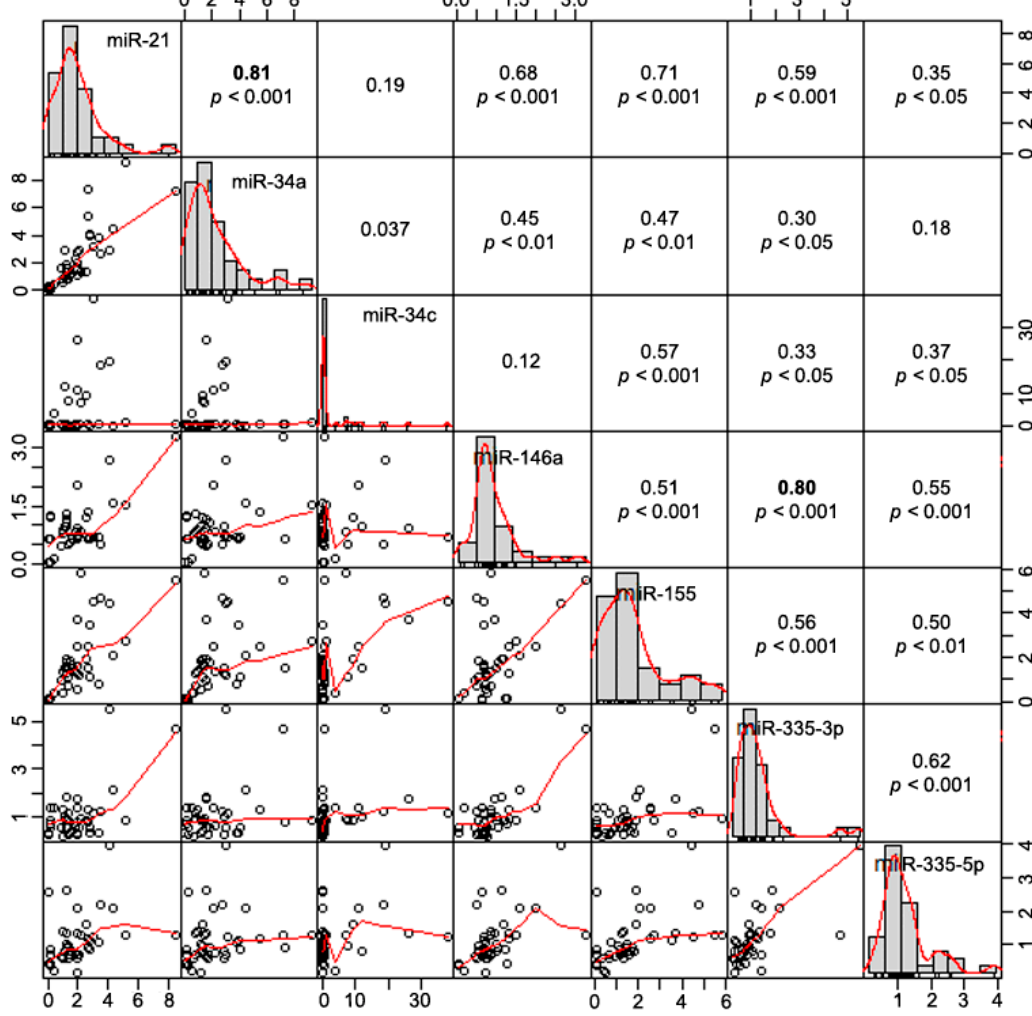
Figure 8. Correlation analysis between each two different miRNAs among iPD patients and healthy control groups in the discovery cohort. Statistically significant correlation ( p < 0.05) and Spearman’s rank correlation coefficient values are indicated in the graphs.